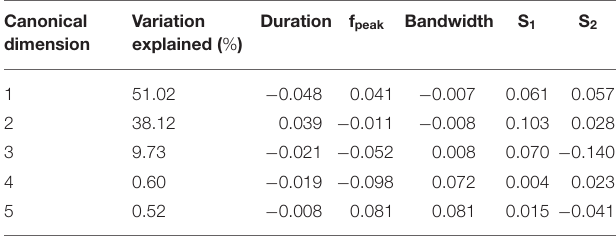
TABLE 2 | Loading scores of call duration, peak frequency (f peak ), bandwidth, average slope of the first half of the call (S 1 ) and average slope of the second half of the call (S 2 ) contributing to the canonical dimensions used in the discriminant function analysis to discriminate call types within Eptesicus fuscus and percentage of variation explained by each dimension.